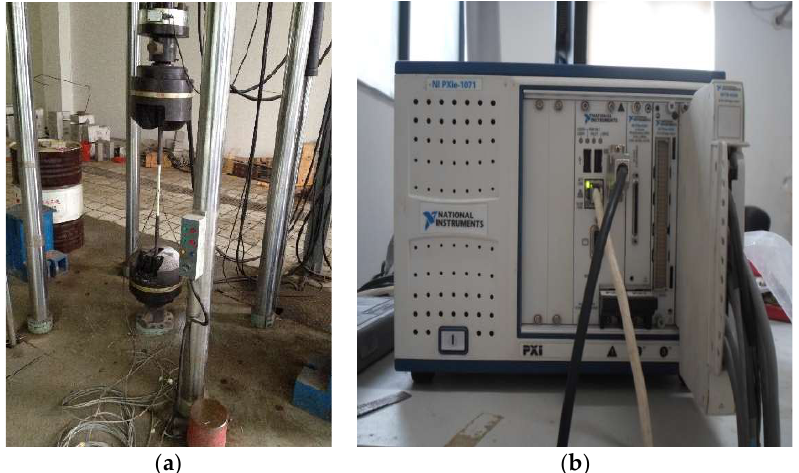
Figure 3. Test instrument: ( a ) 500 kN multifunctional hydraulic testing machine; ( b ) NI data acqui- sition instrument.